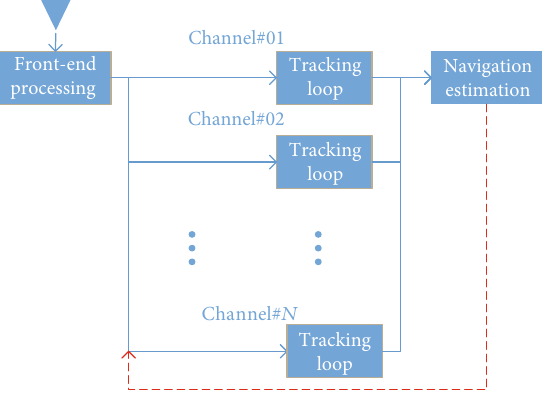
2: Vector Tracking